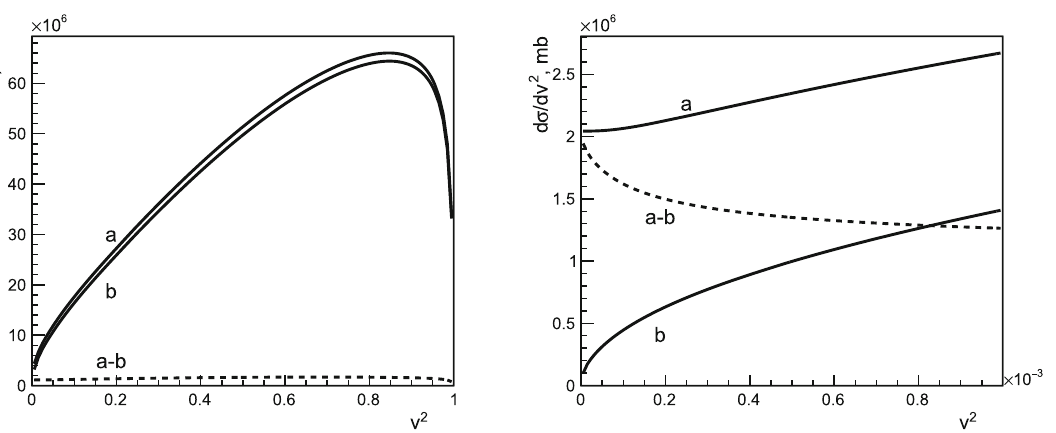
shown by the dashed line. The velocities for the region of small masses √ s nn =11 GeV with are shown in the right-hand side. Note the factor 10 − 3 at the abscissa